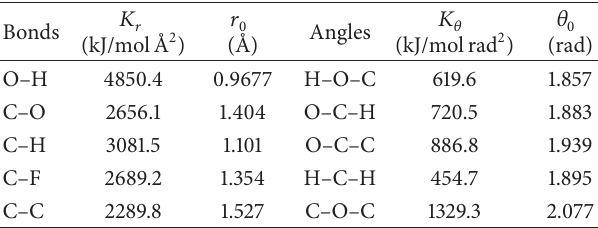
Table 1: Selected parameters for the intramolecular Zdol atomistic model.